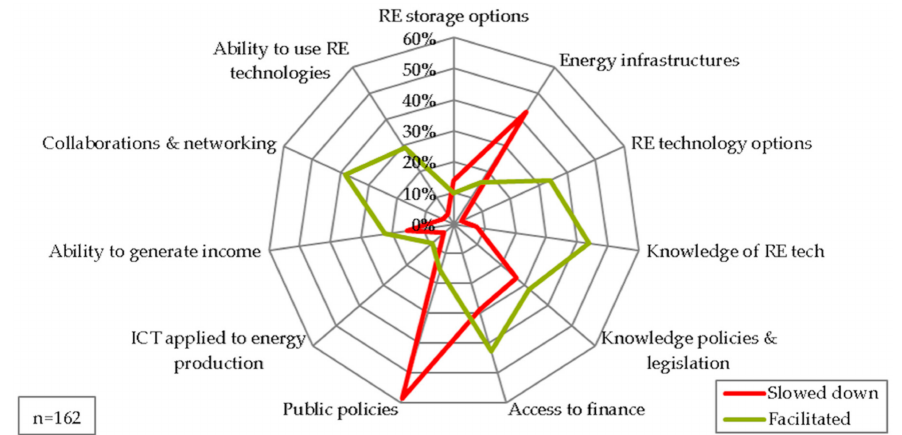
Figure 14. Main hindering (slowing down) and facilitating factors for the development of a prosumer